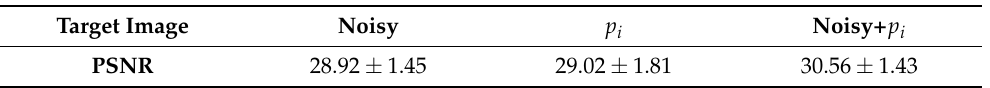
Table 1. The PSNR (dB) performance of the Set12 dataset while taking different images as the learning target of the DIP optimization process.